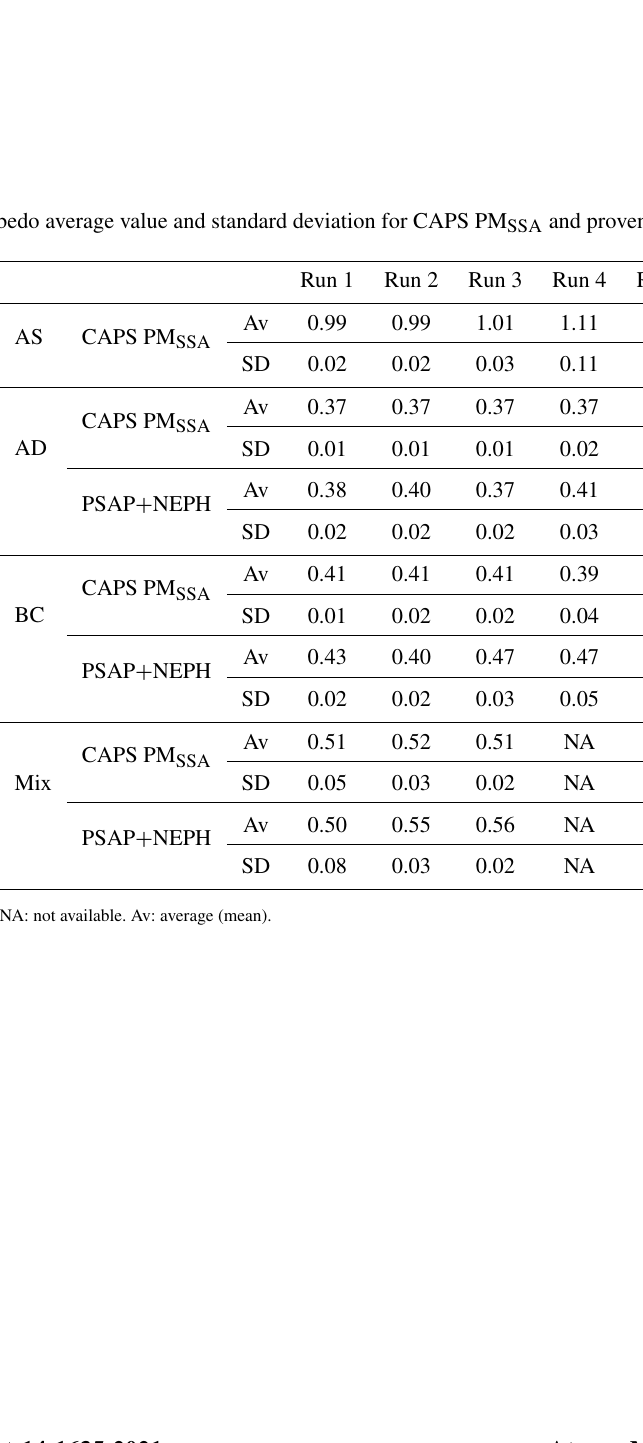
Table A4. Single-scattering albedo average value and standard deviation for CAPS PM SSA and proven technologies.